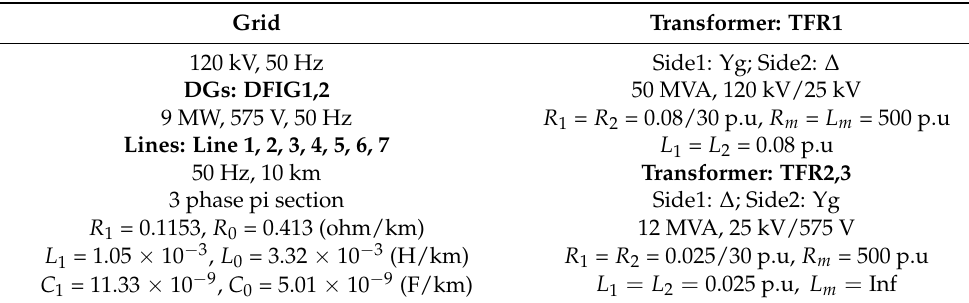
Figure 5. Schematic of the microgrid multiple DGs connected to the grid; Bus: bus bar. Figure 4. Schematic of the microgrid multiple DGs connected to the grid; Bus: bus bar. Table 2. System Table 2. System parameters.